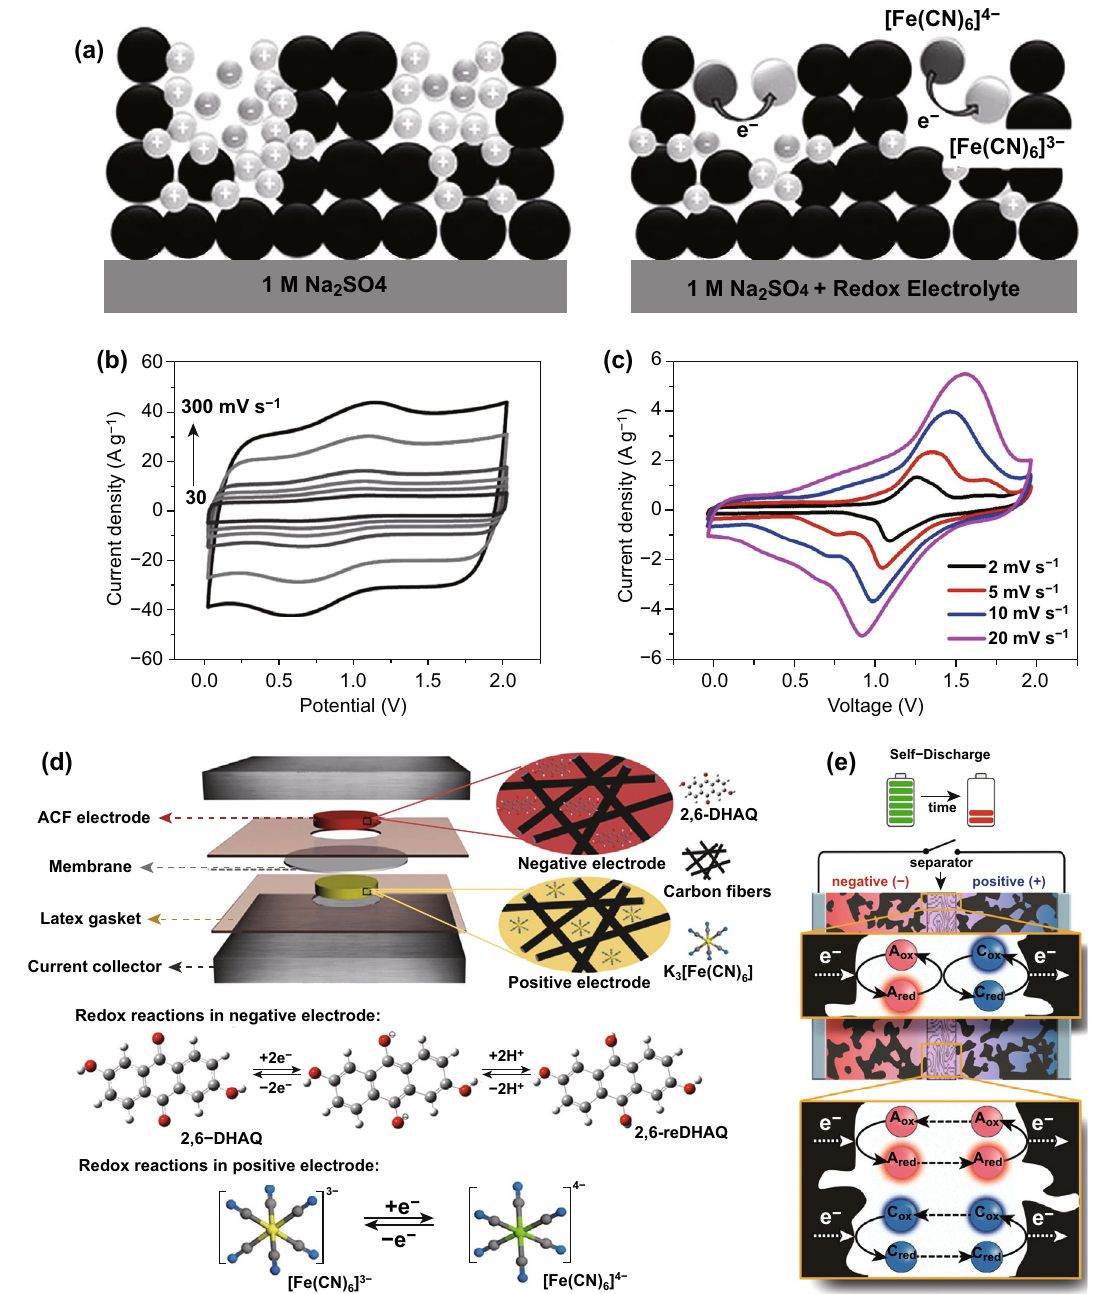
Fig. 7 a Illustration of the charge storage mechanism in an carbon‑based electrode using a 1.0 M Na 2 SO 4 electrolyte (left) in the absence and (right) in the presence of a redox mediator. b CV curves of as‑prepared carbon‑based aqueous SC with different scan rates. Adapted with per‑ mission from Ref. [78]. c CV curves of carbon‑based aqueous SC with various scan rates. d Schematic of the carbon‑based SC with asymmetric redox additive electrolytes and corresponding redox reactions. Adapted with permission from Ref. [70]. e Schematic illustration of the self‑ discharge mechanism. Adapted with permission from Ref.